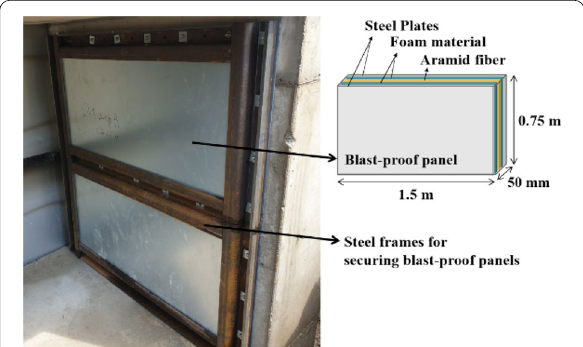
Fig. 1 Composition and attachment of blast‑proof